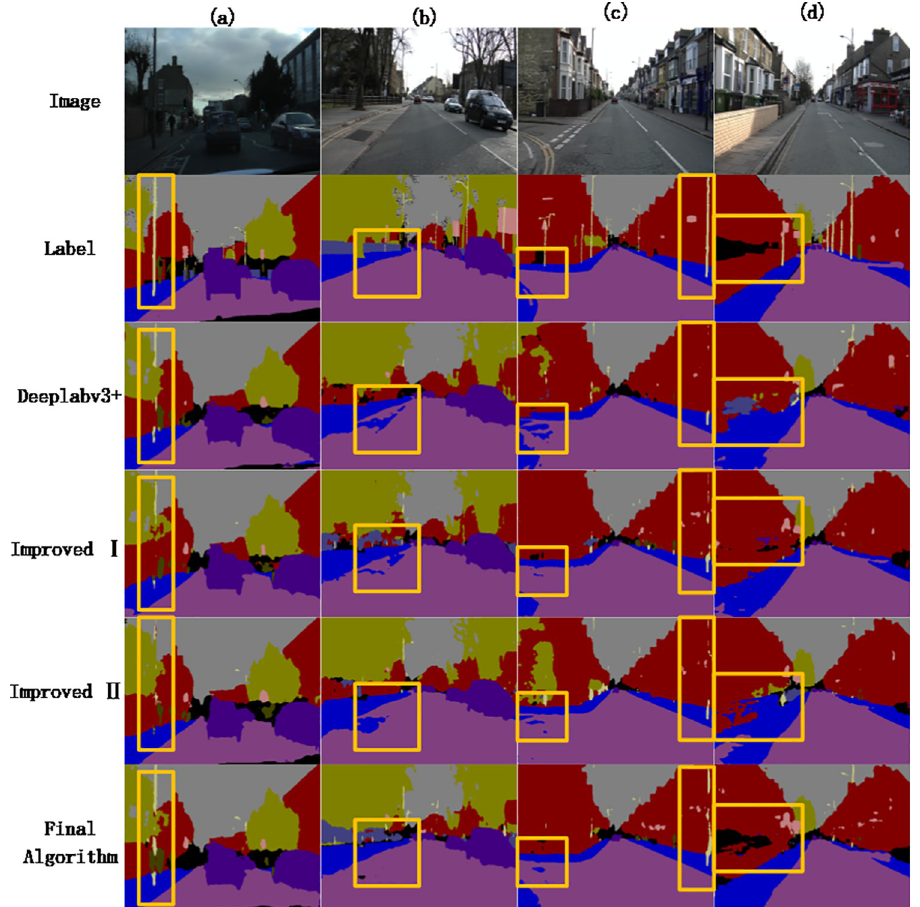
Fig 8. Results of partial segmentation of CamVid dataset. From the image segmentation results in column (a), it can be seen that the Deeplabv3plus algorithm, the Improved I and the Improved II have different degrees of under- segmentation on the street light poles, and the complete street light pole area cannot be segmented. Compared with the above three methods, the proposed algorithm can segment a more complete street light pole area and get more precise details. In view of the images in column (b) and their segmentation results, Deeplabv3plus, Improved I, and Improved II algorithms have different degrees of mis-segmentation in the segmentation of the motor vehicle lane area, and part of the motor vehicle lane area is mistakenly divided into sidewalks. In practical applications, the misclassification of these two semantic categories is a fatal error. The algorithm of this paper, which combines two improved strategies, correctly divides the motor vehicle lanes and sidewalks, and solves the mis-segmentation phenomenon. For the images in column (c) and their segmentation results, the sidewalk on the left and the street lights on the right have different degrees of mis-segmentation, especially in the segmentation results of Deeplabv3plus and the improved algorithm. Although the Improved II segmented the sidewalk area relatively correctly, the streetlight area marked on the right side was seriously under-segmented. The segmentation result of the algorithm in this paper is still relatively rough compared to the label, but compared with the above segmentation result, the error segmentation phenomenon is reduced. In the image (d) and a series of segmentation results, Deeplabv3plus and the Improved I algorithm are not accurate in the segmentation of the marked sidewalk area, while the Improved II algorithm and our algorithm obtain more accurate segmentation